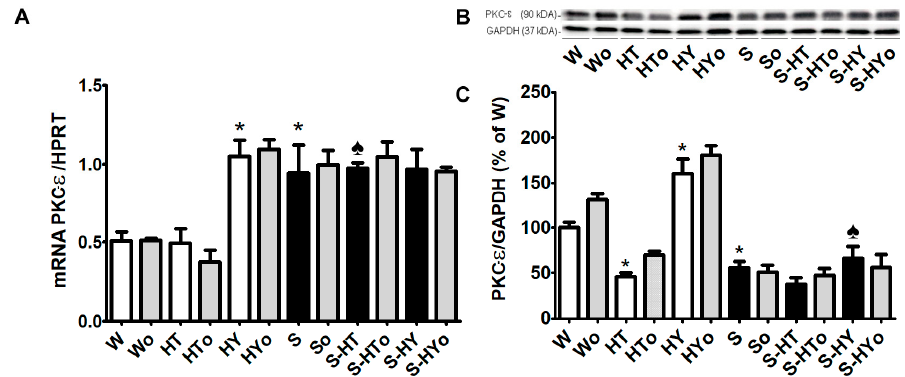
Figure 5. Myocardial expression of protein kinase C epsilon ( PKC- ε ) mRNA normalized to hypoxanthine